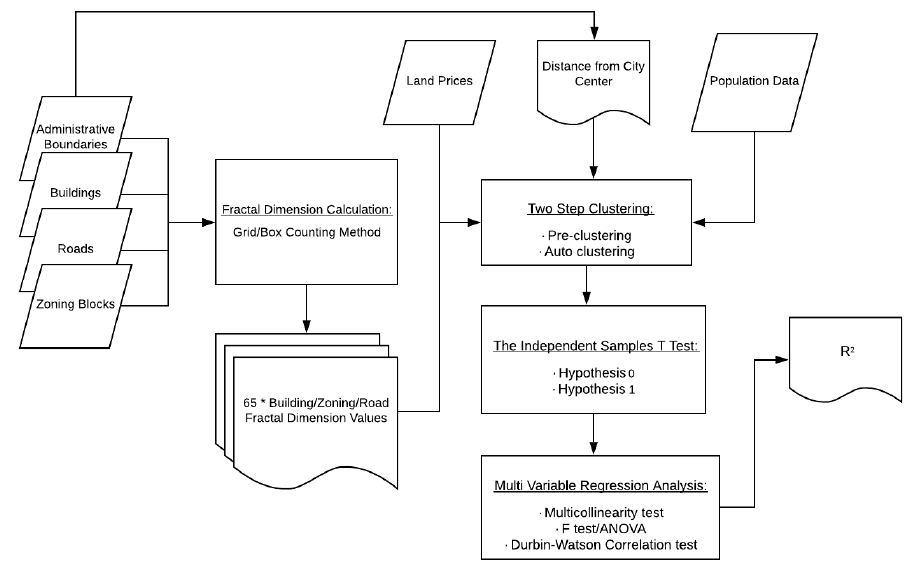
Figure 3. Flowchart for determining relationship between urban geometry and land prices.